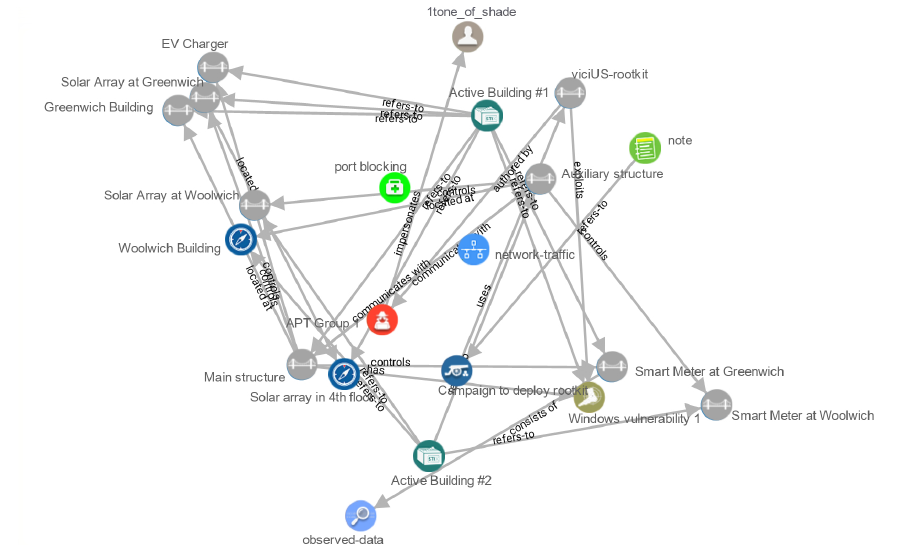
Figure A1. Base STIX model for active buildings that is too complex for the official STIX